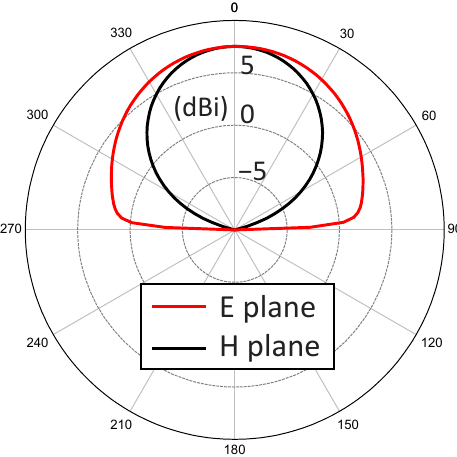
Figure 3. Impedance of the proposed patch antenna at fundamental (f0) and second (2f0)- and third (3f0)-harmonic frequencies (simulation).